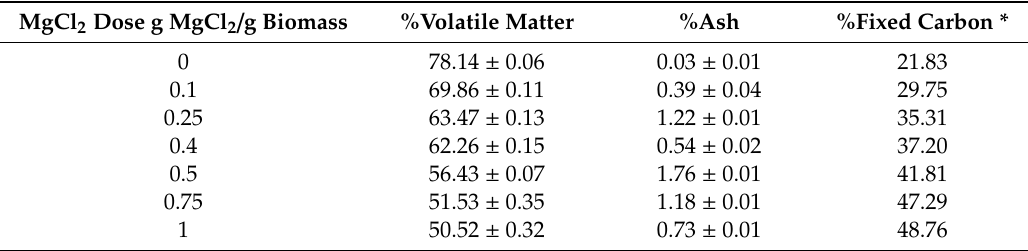
Table 4. Proximate analysis of the carbonized